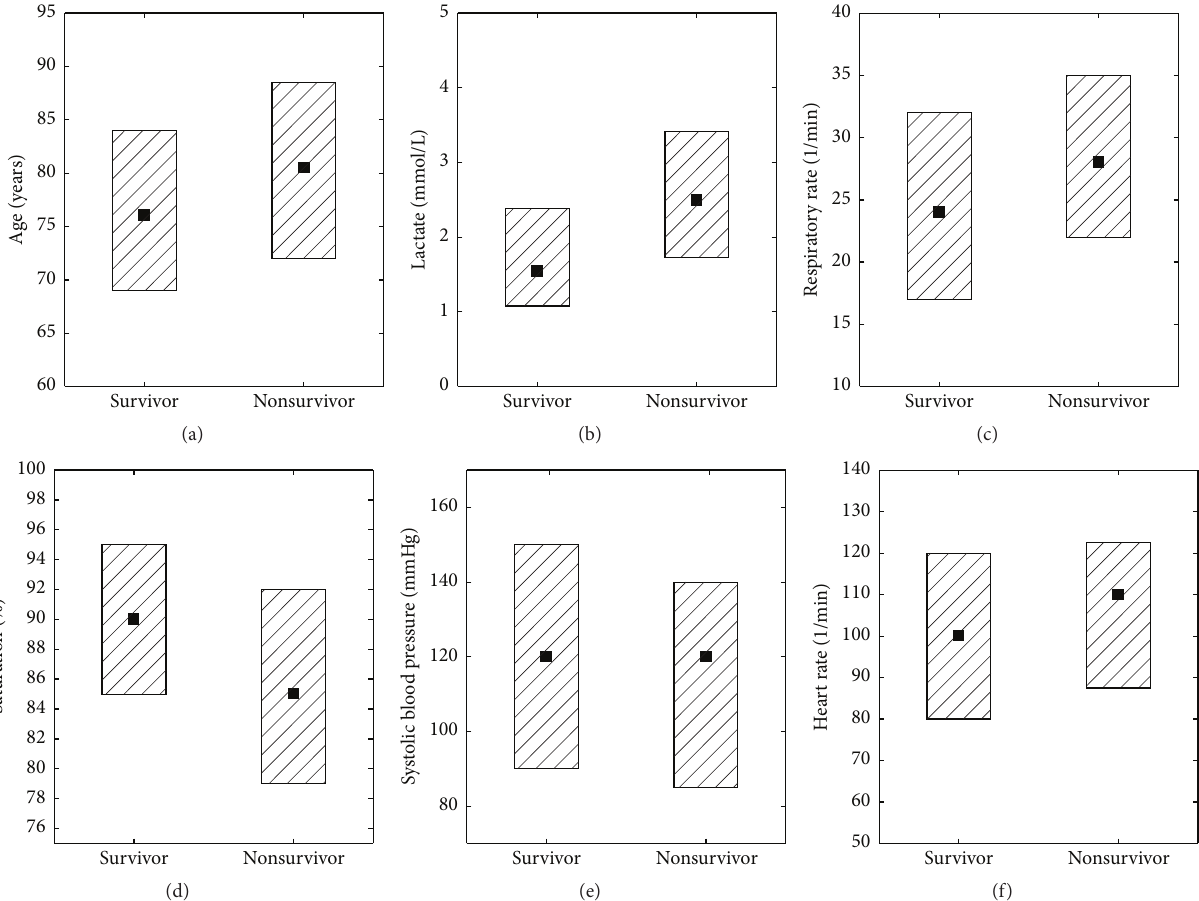
Figure 2: Age (a), lactate (b), respiratory rate (c), saturation (d), systolic blood pressure (e), and pulse (f) in relation to 30-day mortality, 𝑛 = 211 . Square and box indicate median and interquartile range.